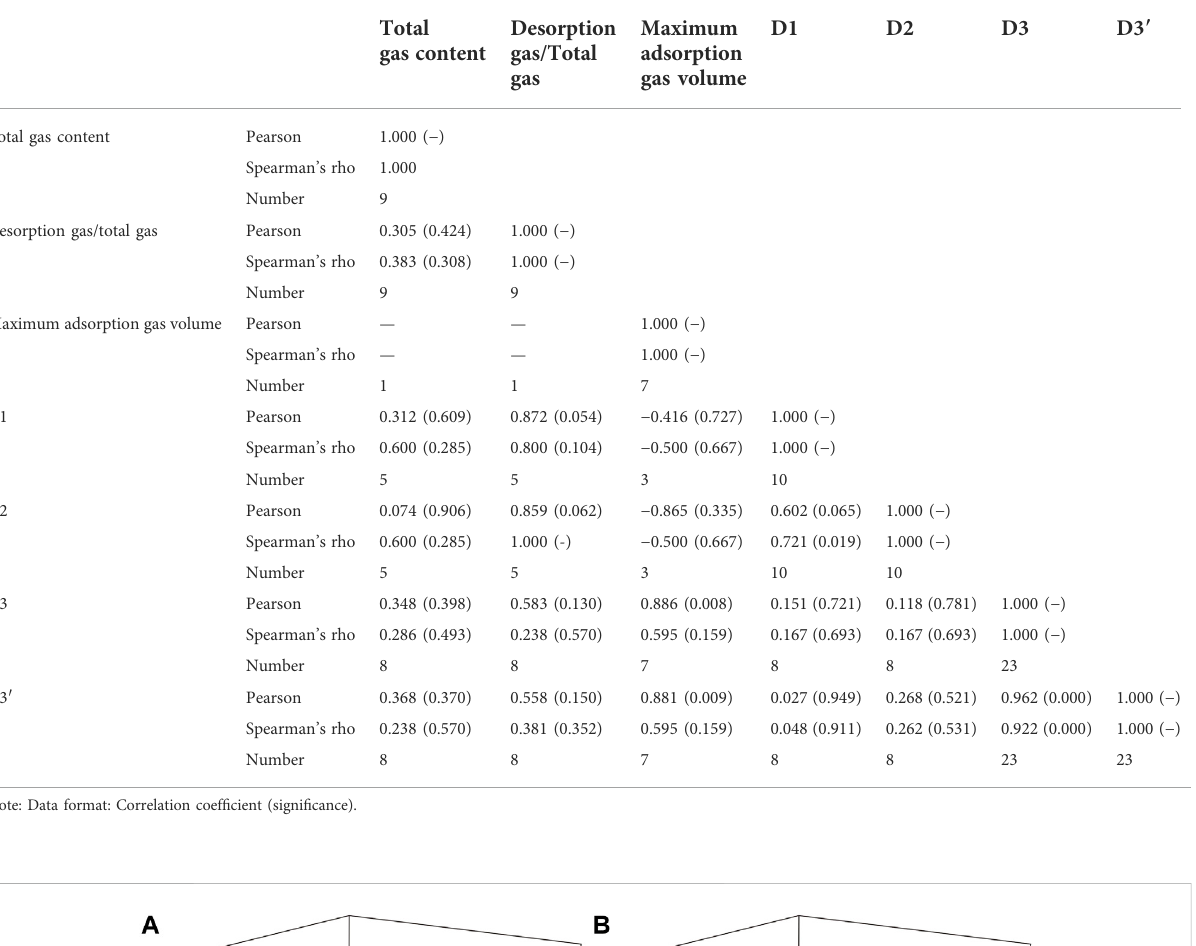
Longtan Formation. For type B shale with developed and complex macro-mesopores, the proportion of gas that can be naturally produced in the total gas is large and easily exploitable.